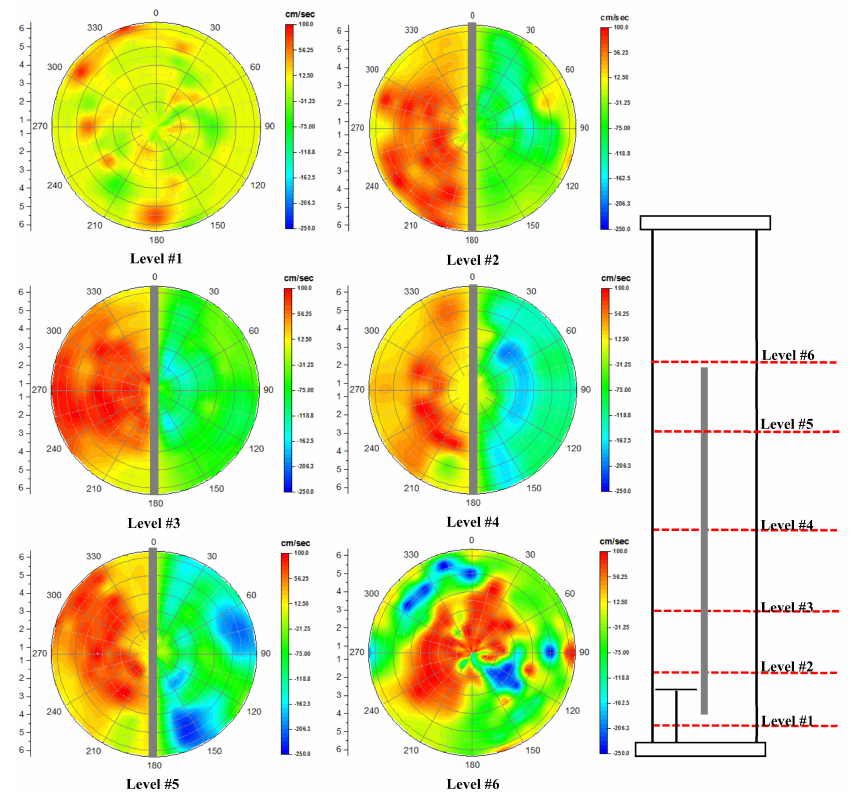
Figure 14. Cross-sectional distributions of axial liquid velocity at different heights of split airlift reactor operated under gas velocity of 3 cm/s.